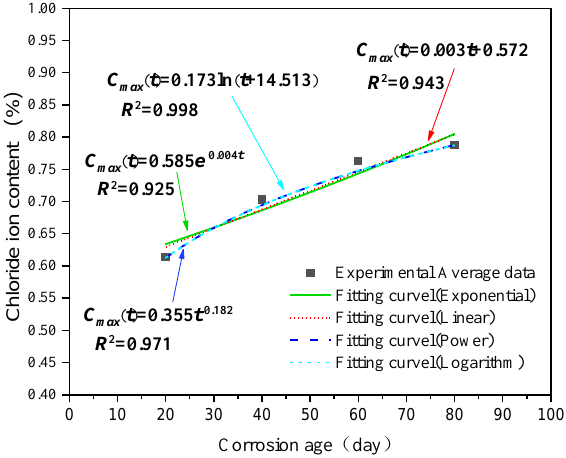
Figure 14. Fitting curve of apparent chloride ion content of SMA-ECC specimensand time. It is clear from the above fitting curve that the exponential function, linear function, power function and logarithmic function correlation coefficient R 2 of SMA-ECC in the dry- wet cycle corrosion environment were 0.925, 0.943, 0.971 and 0.998, respectively. The larger the correlation coefficient R 2 were, the better the fitting effect of the function was, but the fitting situation of the function from the Origin needed to be considered [18]. Therefore, a power function model was used to characterize the law of surface chloride ion content and corrosion age of SMA-ECC in a dry-wet corrosion cycle environment, as shown in formula (4), which showed that the power function can effectively fit the rela- tionship between apparent chloride ion content and time [30]: 0.182 (4) where C max ( t ) represents the maximum chloride ion content (%) on the surface of the spec- imen; t represents the corrosion age (day). 4.6. Apparent Chloride Ion Diffusion Coefficient of Equivalent Chloride Ion The chloride ion erosion direction of the corroded specimen in the chloride salt dry- wet corrosion cycle environment was one-dimensional, and the apparent chloride ion dif- fusion coefficient can be calculated by Fick ’ s second law [17]. The calculation formula (5) is as follow: